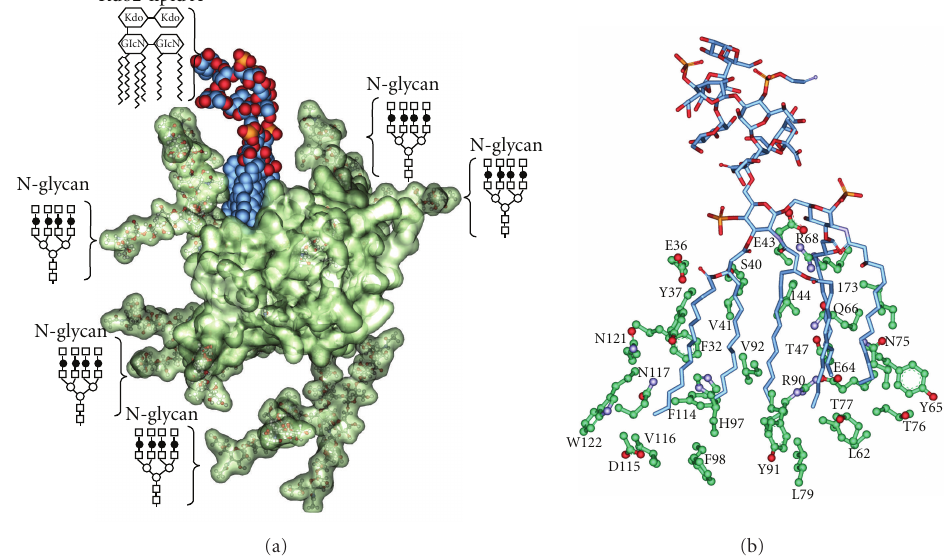
Figure 4: Molecular model of the Kdo2-lipid A F1 ∗ S AGP complex. (a) The AGP F1 ∗ S variant crystal structure (PDB code: 3KQ0) is shown in semitransparent surface representation, the bound Kdo2-lipid A is shown in CPK, carbon is colored blue. The Kdo2-lipid A and quaternary N -glycans on the AGP structure are indicated schematically ( (cid:8) Man; (cid:2) GlcNAc; (cid:2) d -Gal) and are shown in ball- and stick- representation on the model. (b) Interactions between the fatty acyl chains of lipid A and the side chains of the ligand binding cavity of